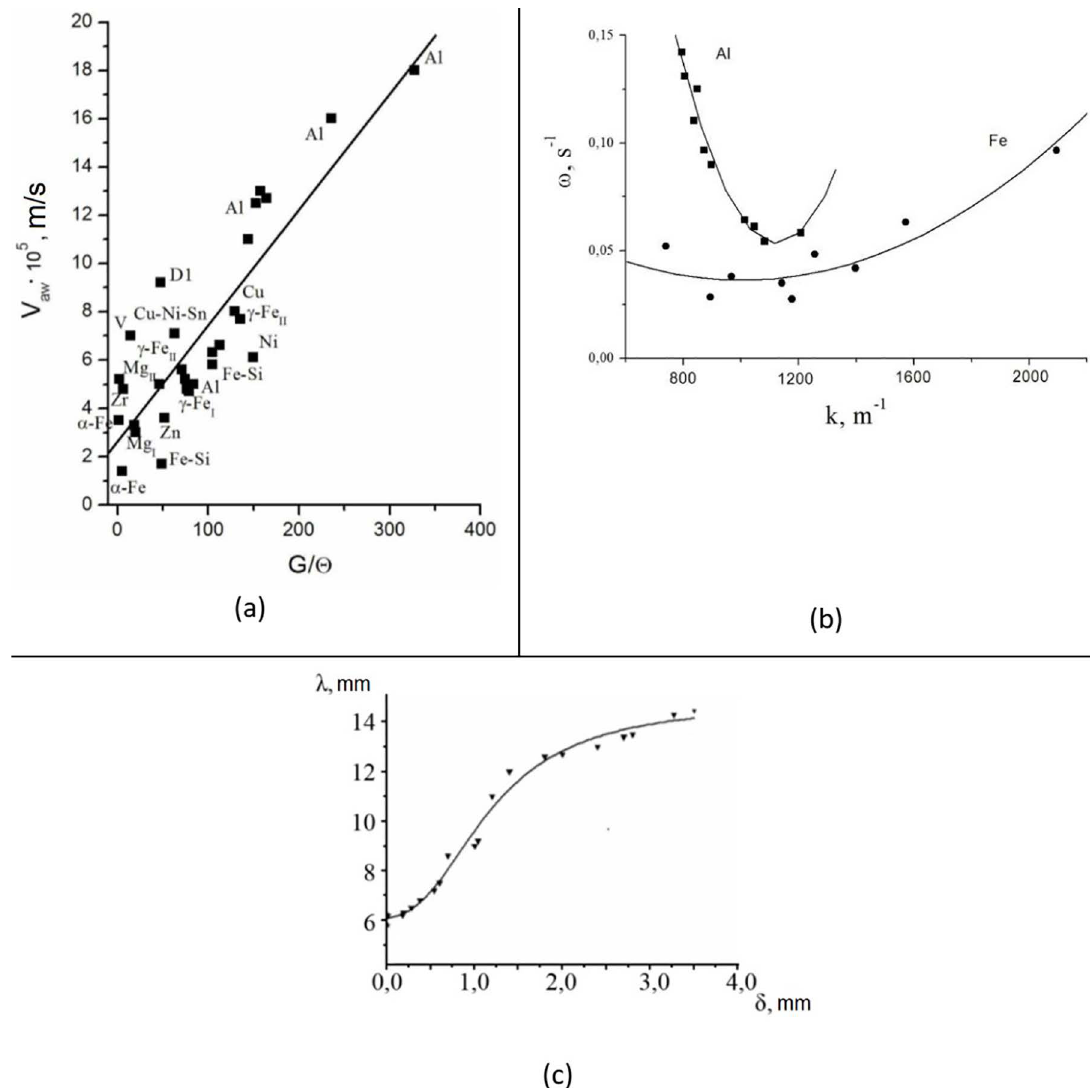
Figure 3. Distinctive features of localized plasticity autowaves (а) work hardening coefficient dependence of autowave rate; (b) dispersion relation; (c) grain size dependence of autowave